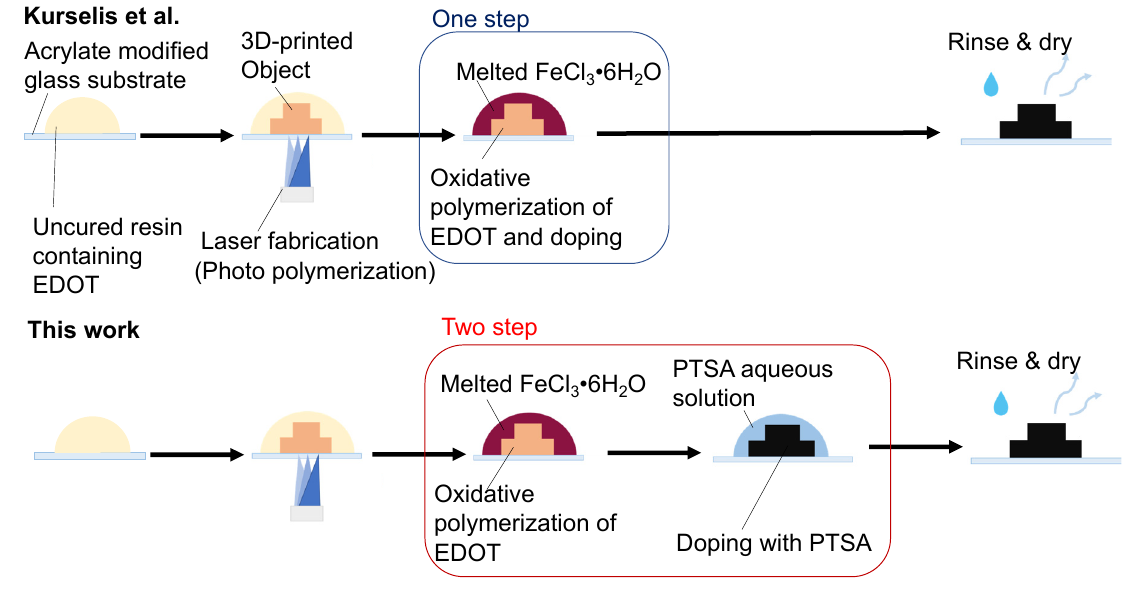
Figure 1. Schematic of different post-curing processes between Kurselis et al. [19] and this study.